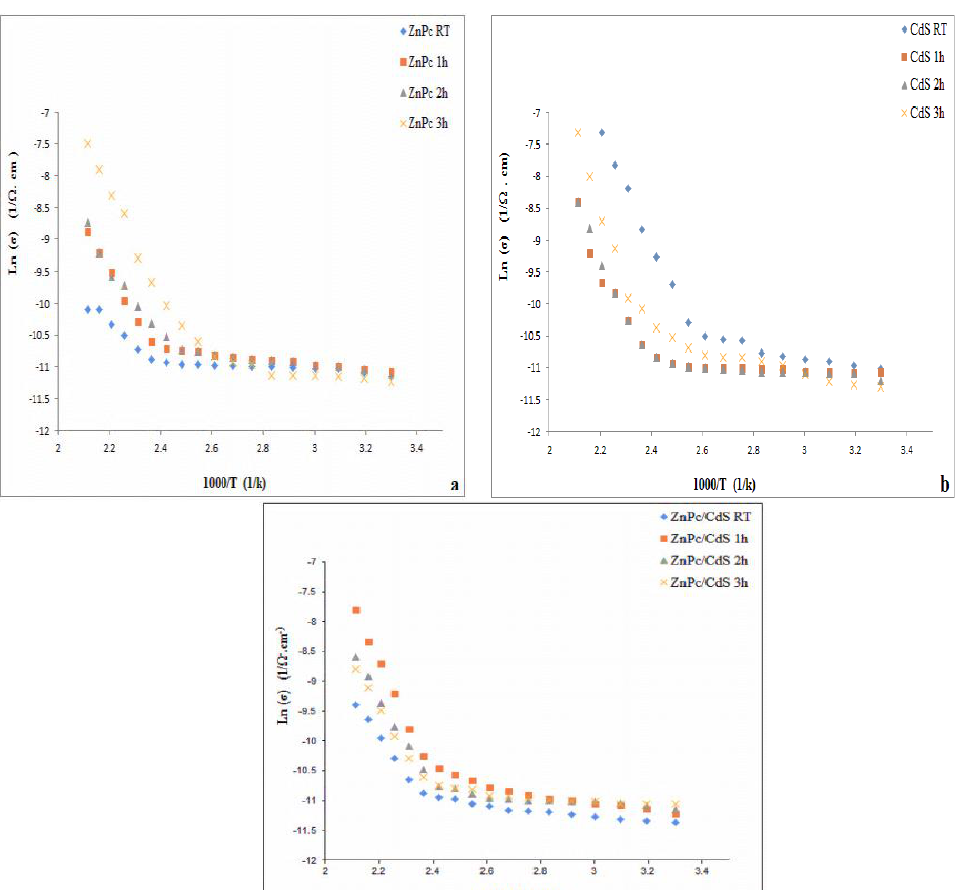
Fig.4: The relation between Ln (σ) versus reciprocal of temperature for s-deposited and annealed a:ZnPc, b:CdS and c:blended films for 423K at different annealing